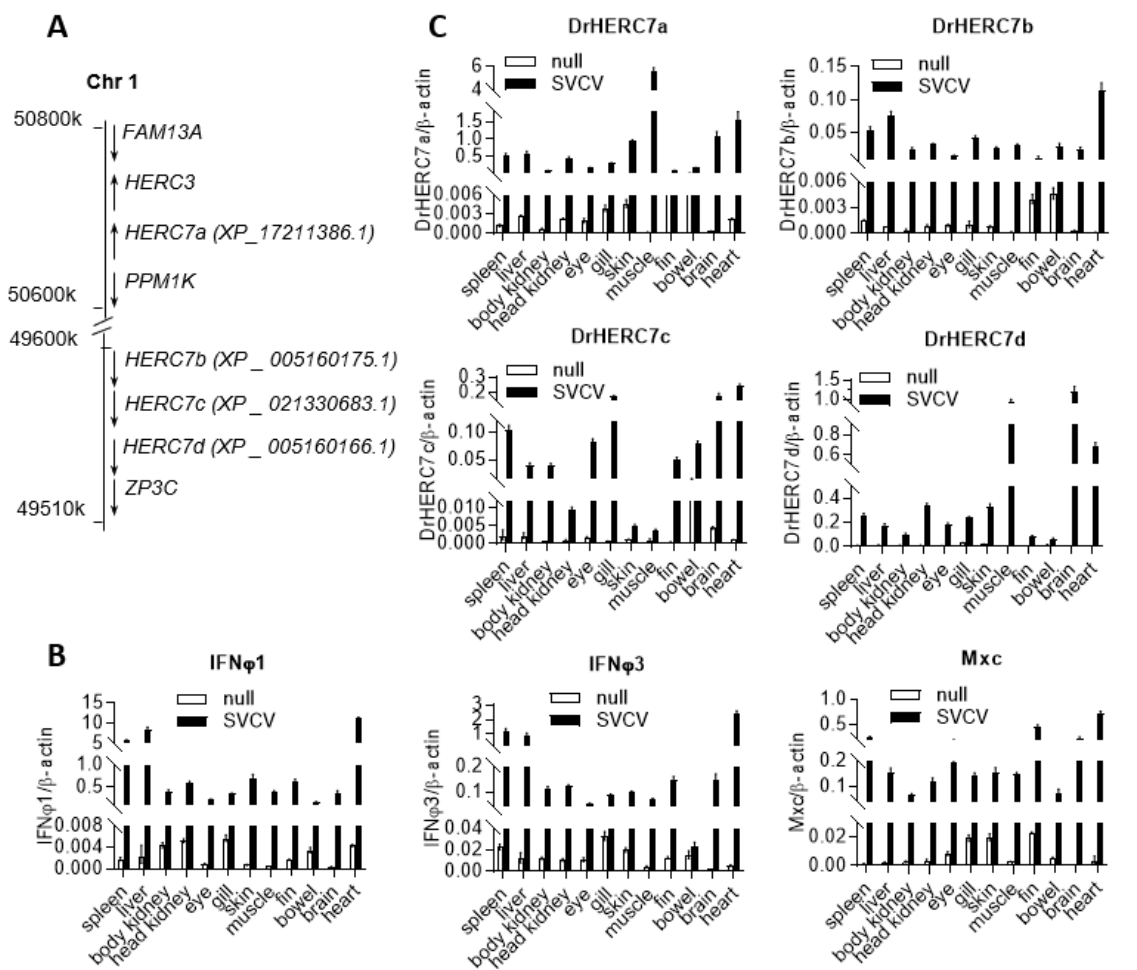
Figure 1. Zebrafish has four herc7 genes that are induced by SVCV infection. ( A ) Schematic representation of zebrafish herc3 gene locus containing four herc7 homologous genes. ( B , C ) Four zebrafish herc7 genes were transcriptionally induced in SVCV-infected zebrafish tissues. Zebrafish adults were intraperitoneally injected with SVCV for 48 h, followed by RT-PCR analyses of ifnφ1, ifnφ3 , and mxc ( B ), as well as herc7a-d ( C ), in different zebrafish tissues.